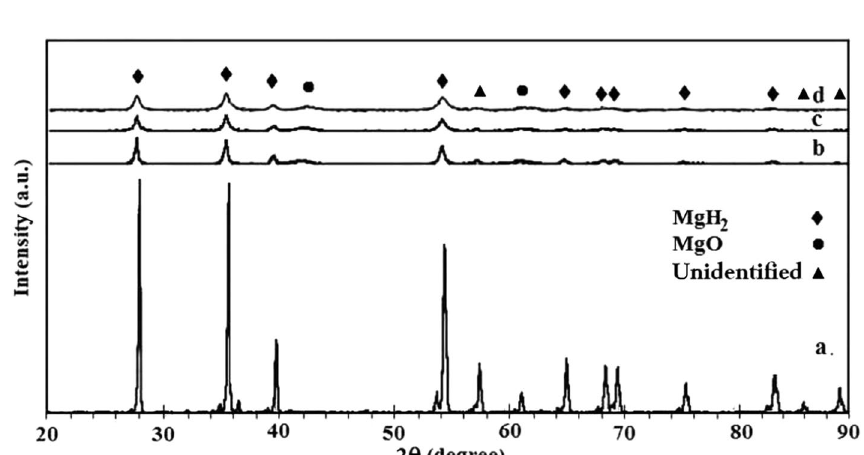
Fig. 3 XRD patterns of a